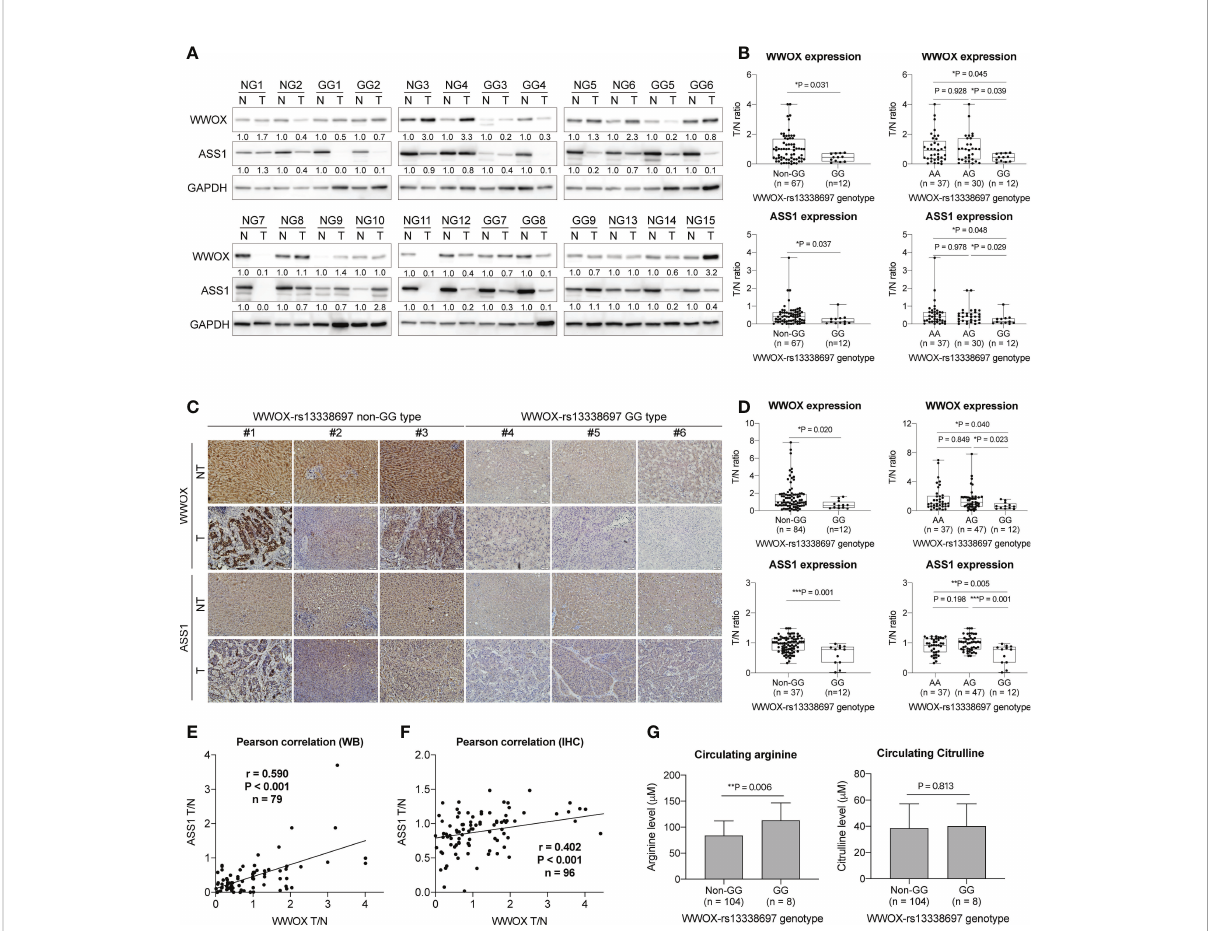
FIGURE 6 The WWOX -rs13338697 genotypes correlates with WWOX and ASS1 expression in HCC. (A) Western blot analysis of WWOX and ASS1 in patient- derived tissues. NG, Non- WWOX -rs13338697-GG genotype; GG, WWOX -rs13338697-GG genotype; N, Non-tumor; T, Tumor. Quanti fi cation results generated from (A) are summarized in (B) . T/N, Tumor/Nontumor ratio. (C) IHC analysis of WWOX and ASS1 in patient-derived sections. Quanti fi cation results generated from (C) are summarized in (D) . P values were obtained by two-tailed unpaired student t -test, and < 0.05 was considered signi fi cant. Pearson correlation of levels of ASS1 T/N and WWOX T/N generated using (E) Western blot analysis (WB) and (F) IHC are shown. (G) Arginine and Citrulline levels measured using plasma derived from cohort-1 patients. P values were obtained by two-tailed unpaired student t -test, and < 0.05 was considered signi fi cant. *P < 0.05; **P < 0.01; ***P <